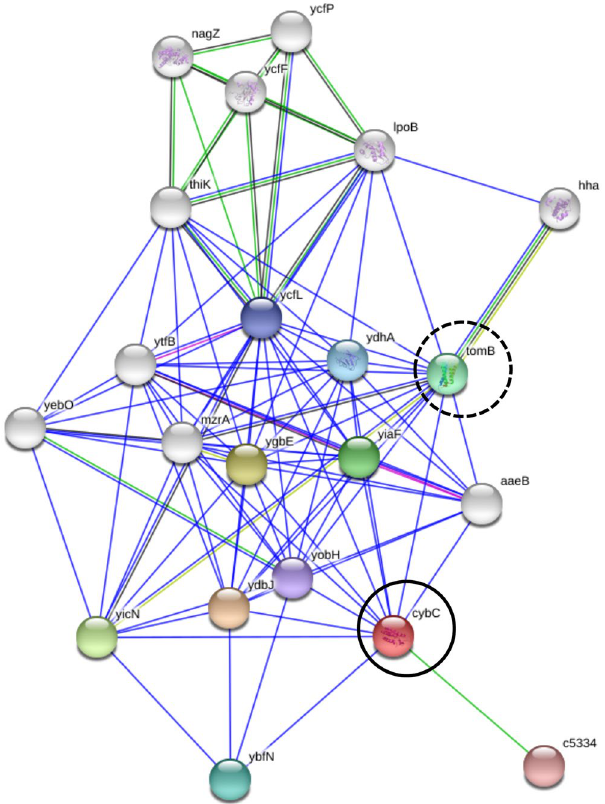
Figure 4. Protein-protein interaction of cybC coding soluble cytochrome b562 predicted using the STRING database (https://string-db.org). The organism database used Escherichia coli CFT073 from a urinary tract infection. The STRING interaction map was generated using default settings (medium confidence of 0.400; criteria for linkages are neighbourhood, gene fusion, co-occurrence, co-expression, experiments, databases and text mining). The circle indicates cybC , and the dashed-line circle indicates tomB showing interaction with cybC . The tomB is the coding gene of a biofilm formation